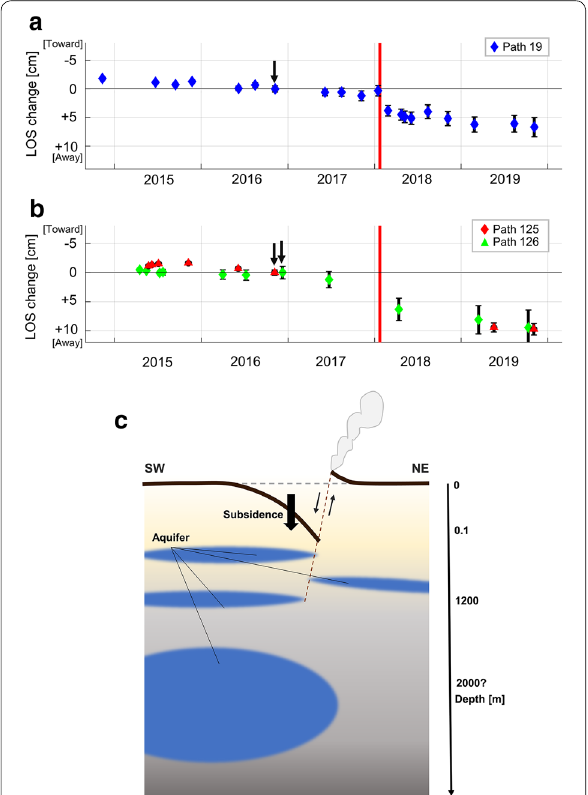
Fig. 4 Time series of line-of-sight (LOS) changes on Moto-Shirane volcano based on PALSAR-2 multi-temporal InSAR analysis. a , b Time series of LOS change on the southwestern side of the eruptive crater on Moto-Shirane volcano in path 19 and in paths 125/126, respectively. c Conceptual model of the 2018 Kusatsu-Shirane phreatic eruption. Note that positive LOS changes (distance changes away from the satellite) indicate downward movement. We set the reference date to November–December 2016, as shown by the black arrows, because of the differences in the first SAR image acquisition periods along each path. Vertical bars behind each plot are standard deviations of LOS changes within a range of 500 m by 500 m at 2 km from the 2018 eruption crater to the east, where we assume little deformation